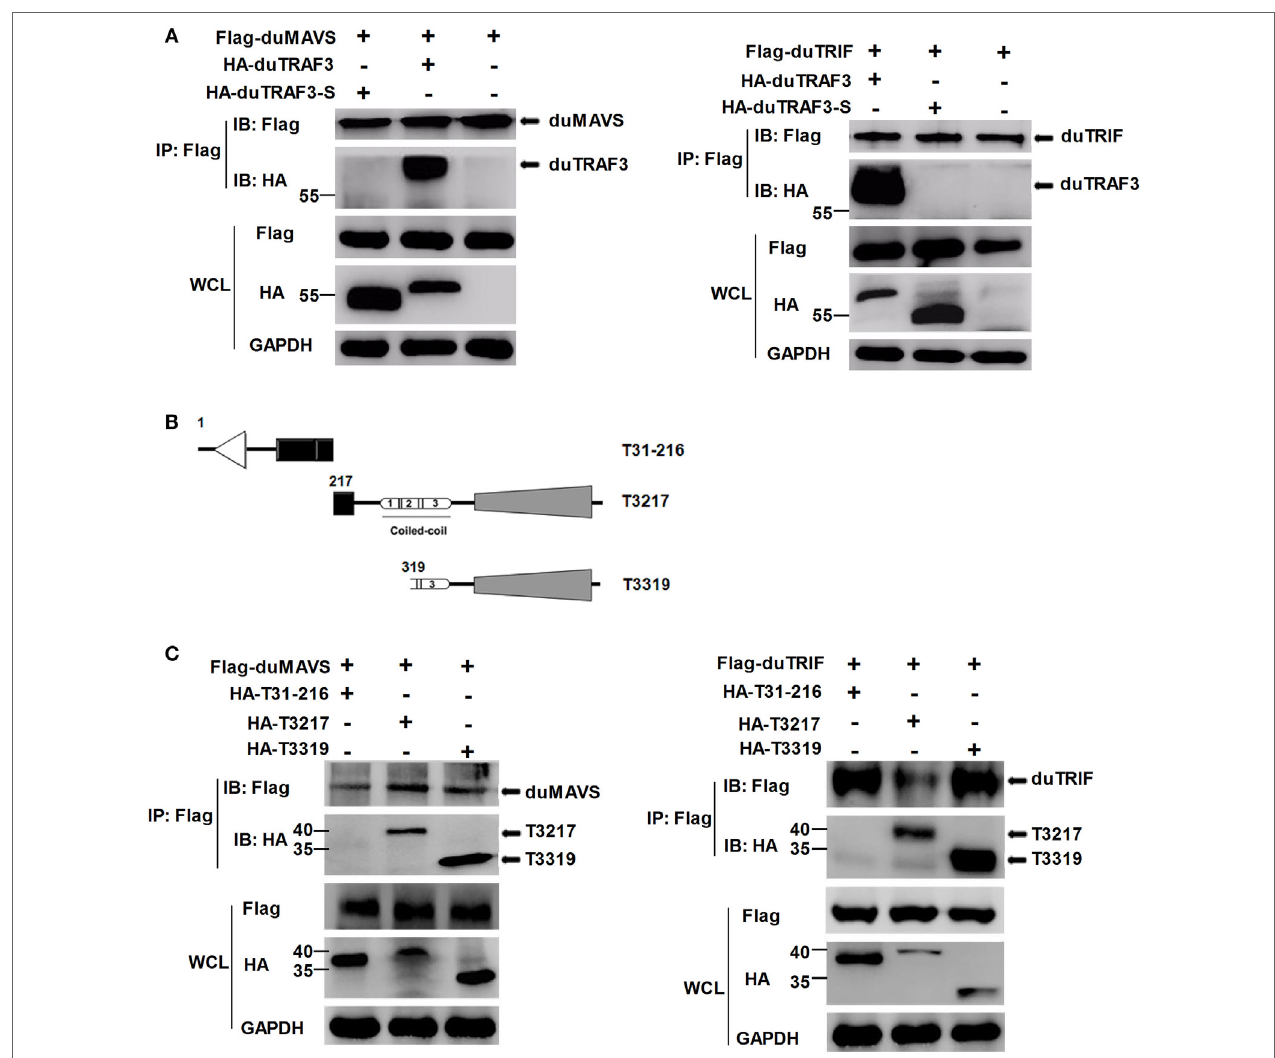
FigUre 4 | duMAVS or duTRIF interact with duck TRAF3 (duTRAF3) and the TRAF domain of duTRAF3, but not spliced isoform of duTRAF3 (duTRAF3-S). (a) Plasmids encoding Flag-tagged duMAVS or duTRIF were cotransfected with HA-tagged duTRAF3 or duTRAF3-S in 293T cells. The cells were lysed 24 h after transfection and subjected to immunoprecipitation with anti-Flag antibody. The immunoprecipitation complexes were analyzed by western blotting using anti-Flag and anti-HA antibodies. (B) Schematic map of the duTRAF3 mutants (T31-216, T3217, T3319). (c) Cells were cotransfected Flag-tagged duMAVS or duTRIF with HA-tagged different duTRAF3 mutants, and then immunoblotting analysis was performed as described above. Co-Immunoprecipitation (Co-IP) was performed with anti-FLAG, and the precipitates were probed with anti-Flag and